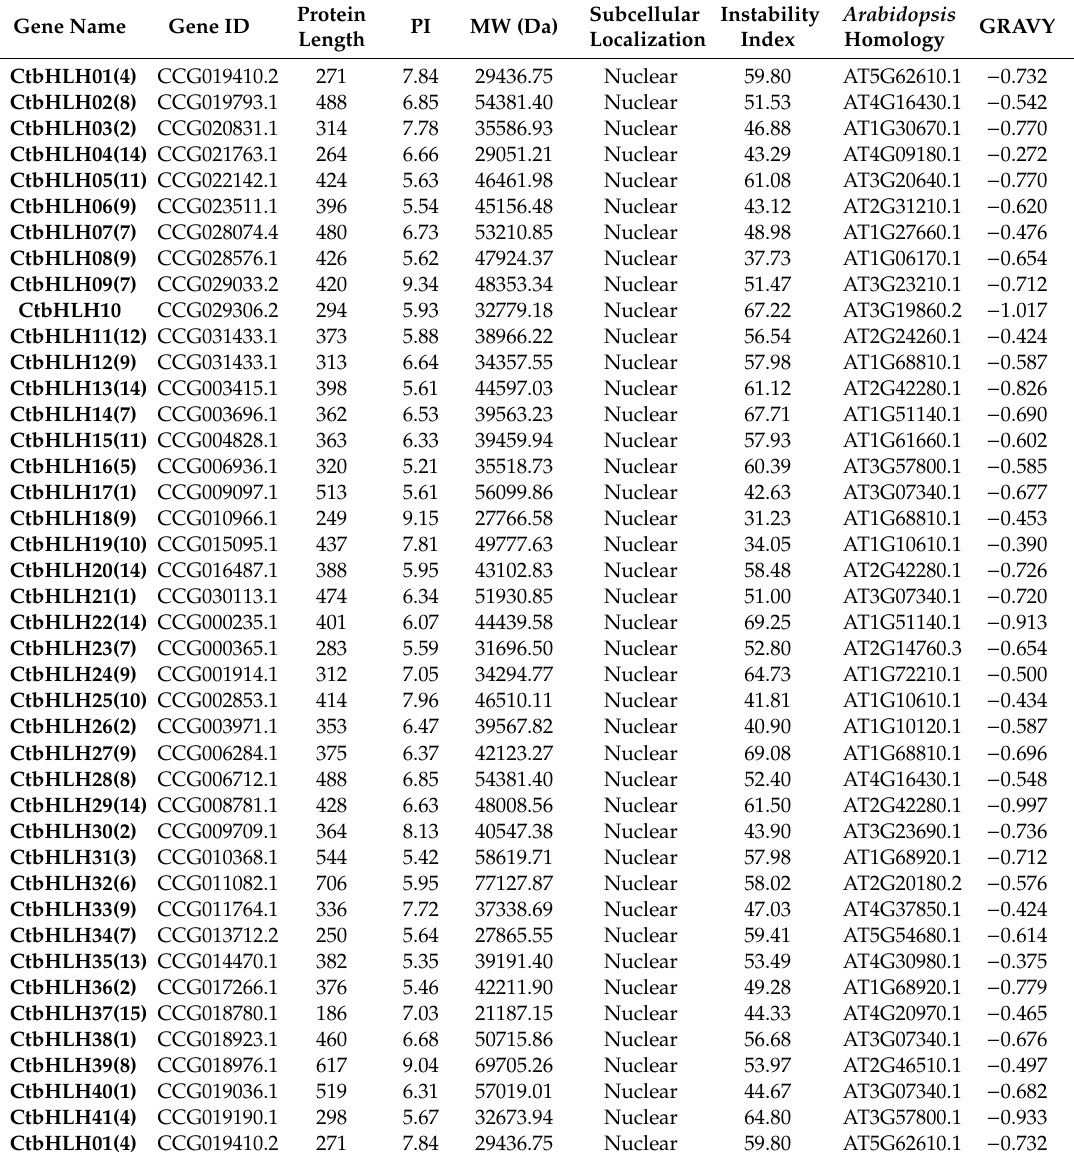
Table 1. Complete list of sa ffl ower bHLH protein family genes and their physiochemical properties. Information provided includes gene names, gene Ids, theoretical subcellular localization, coding sequence (CDS), protein length, molecular weight (MW; Da), and theoretical isoelectric points (PI). These data were obtained from ExPASy (available online: http: // web.expasy.org / protparam /